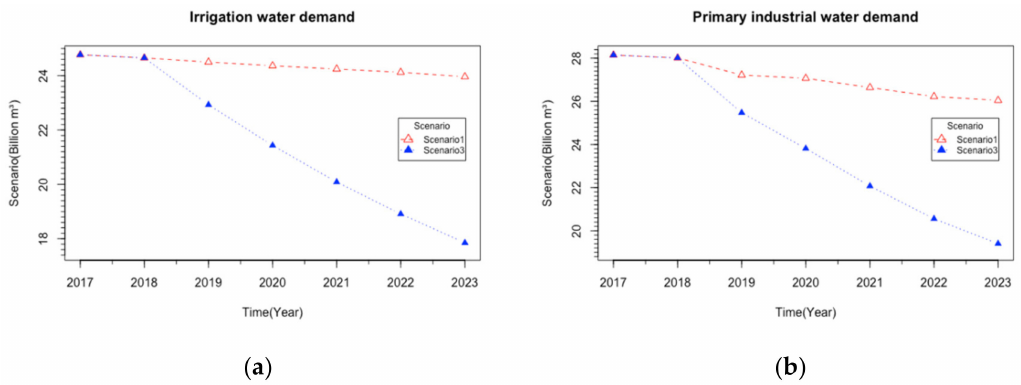
Figure 10. Scenario 3 simulation results: ( a ) Trend of irrigation water demand; ( b ) Trend of primary industrial water demand.